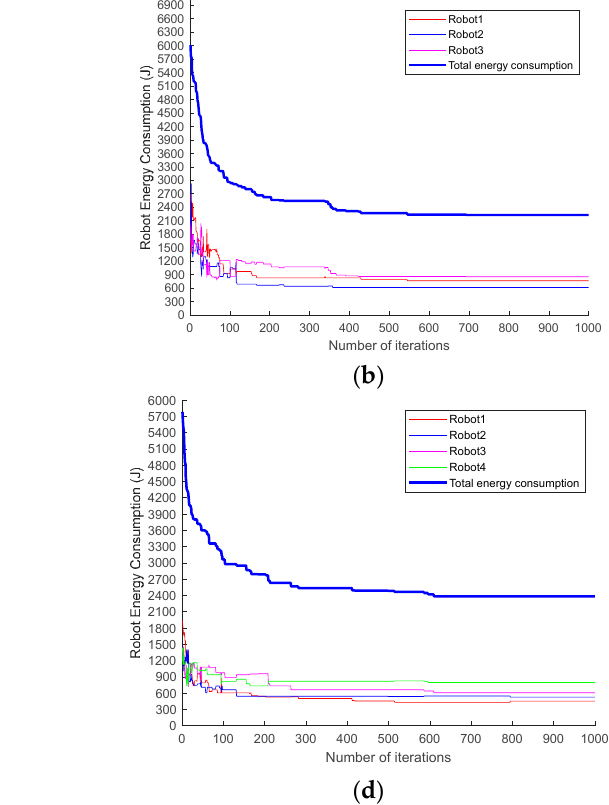
Figure 12. Iterative curve of robot energy consumption in Experiment 2: ( a ) algorithm in this paper ( m = 40, n = 3); ( b ) basic genetic algorithm ( m = 40, n = 3); ( c ) algorithm in this paper ( m = 40, n = 4); ( d ) basic genetic algorithm ( m = 40, n = 4).